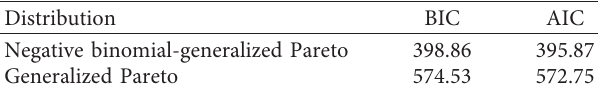
Table 7: Comparison of the quality of